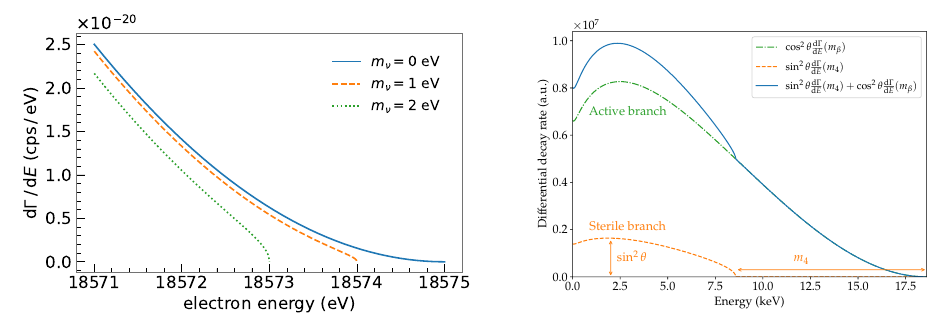
Figure 1. (Left) Illustration of the shape distortion induced by the neutrino mass on the tritium β -decay spectrum. (Right) Illustration of the sterile neutrino signature in a di ff erential tritium β -decay spectrum. For the sake of clarity, a sterile neutrino with a mass of 10 keV and an unrealistic large mixing angle is